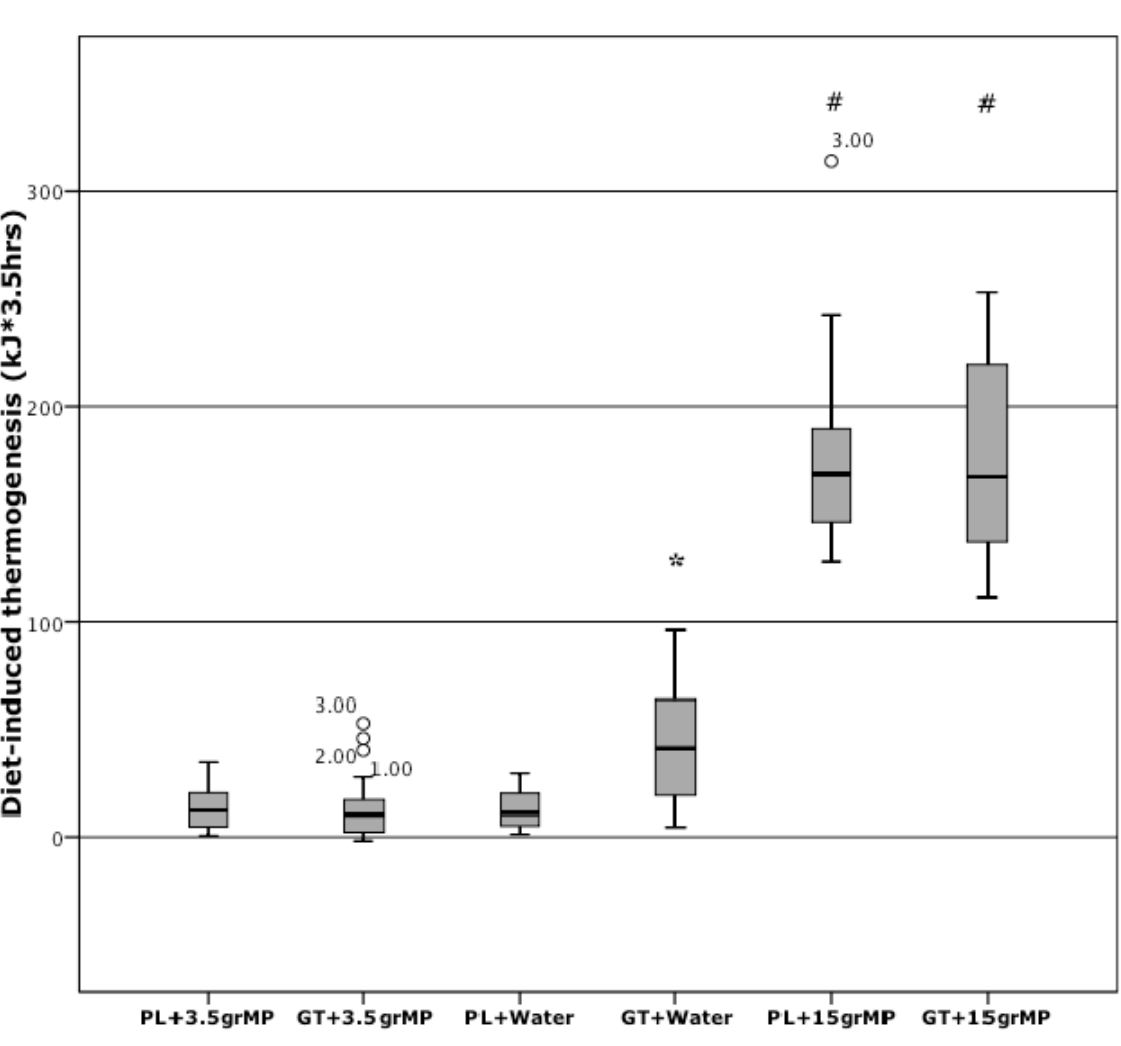
Figure 1. Areas under the curve (AUCs) for energy expenditure after the GT +